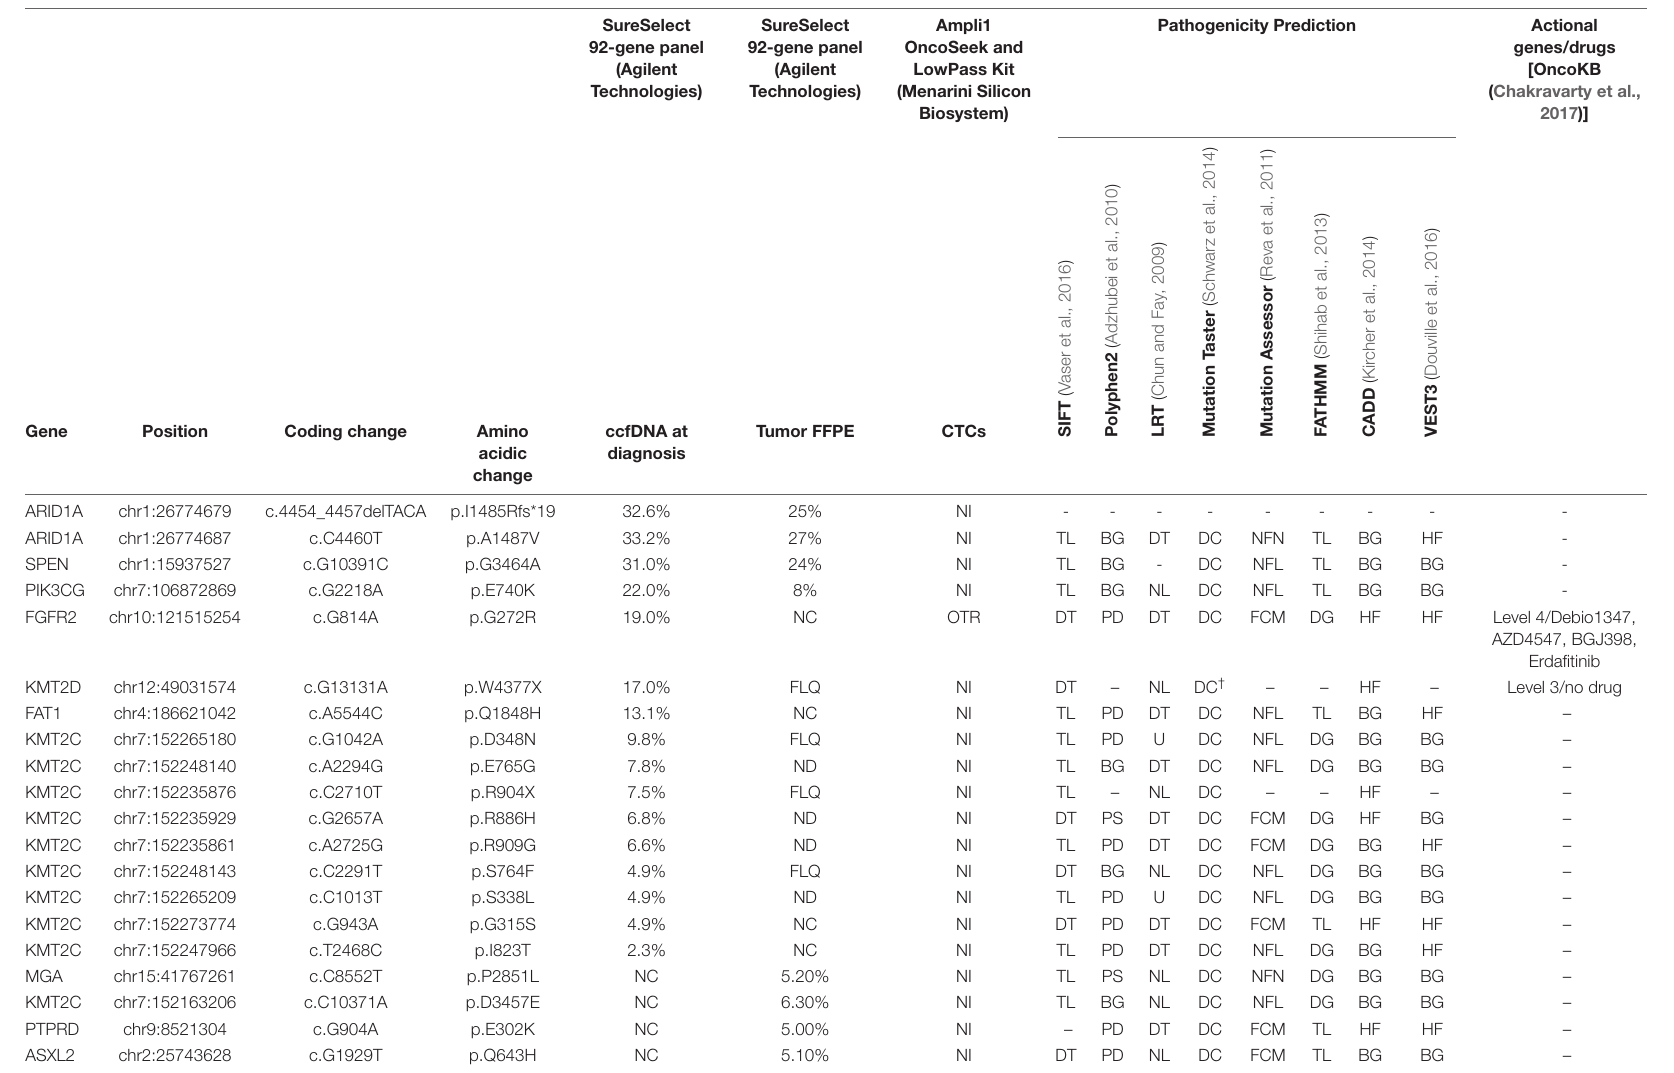
TABLE 2 | Mutation report of tumor, ccfDNA and CTCs from